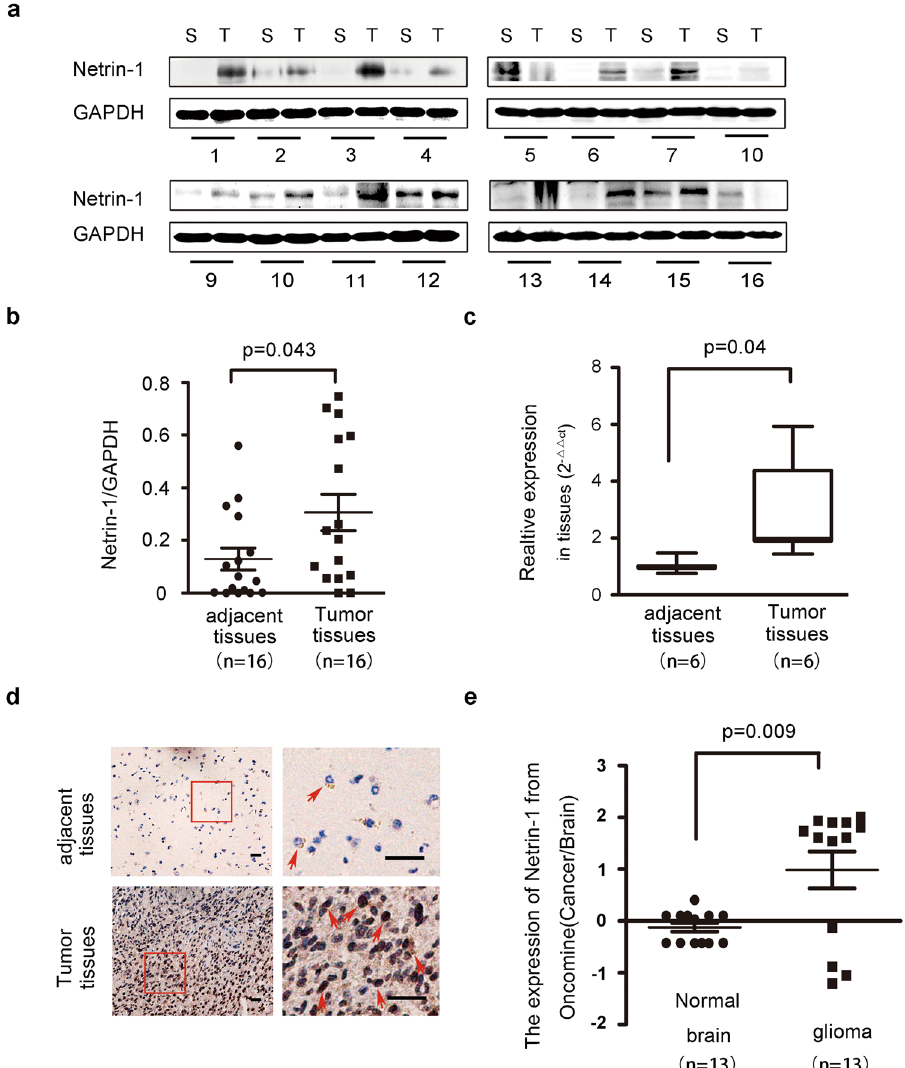
Figure 1. Netrin-1 expression was elevated in glioma tissue specimens. ( a ) Western blotting analyses of netrin-1 expression in fresh tumor tissues (T) and their adjacent normal tissues (S) from 16 patients (No. 1–16). Netrin-1 expression was significantly higher in glioma tumor tissues. GAPDH was used as a loading control. ( b ) Quantification of netrin-1 expression using Gel-Pro Analyzer 4 software. The values indicated the relative netrin-1 expression in the fresh samples. ( c ) Real-time PCR analysis of netrin-1 expression in 6 paired glioma tissues and adjacent normal brain tissues. The results represent data from three independent experiments. ( d ) IHC staining of human glioma cancer samples showing netrin-1 expression. Boxed areas in the left row are magnified and shown in the right row. Red arrowheads indicated examples of cells with positive netrin-1 staining. Scale bar: 50 μ m. ( e ) Expression analysis of netrin-1 in normal brain and glioma samples from the Oncomine cDNA microarray database. The data are shown as the mean ±